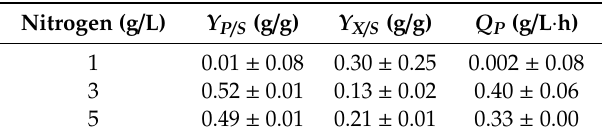
Table 6. E ff ect of the nitrogen concentration on the fermentation parameters obtained during the production of itaconic acid by A. terreus from cellulose pulp hydrolysate. Nitrogen (g / L) Y P / S (g / g) Y X / S (g / g)